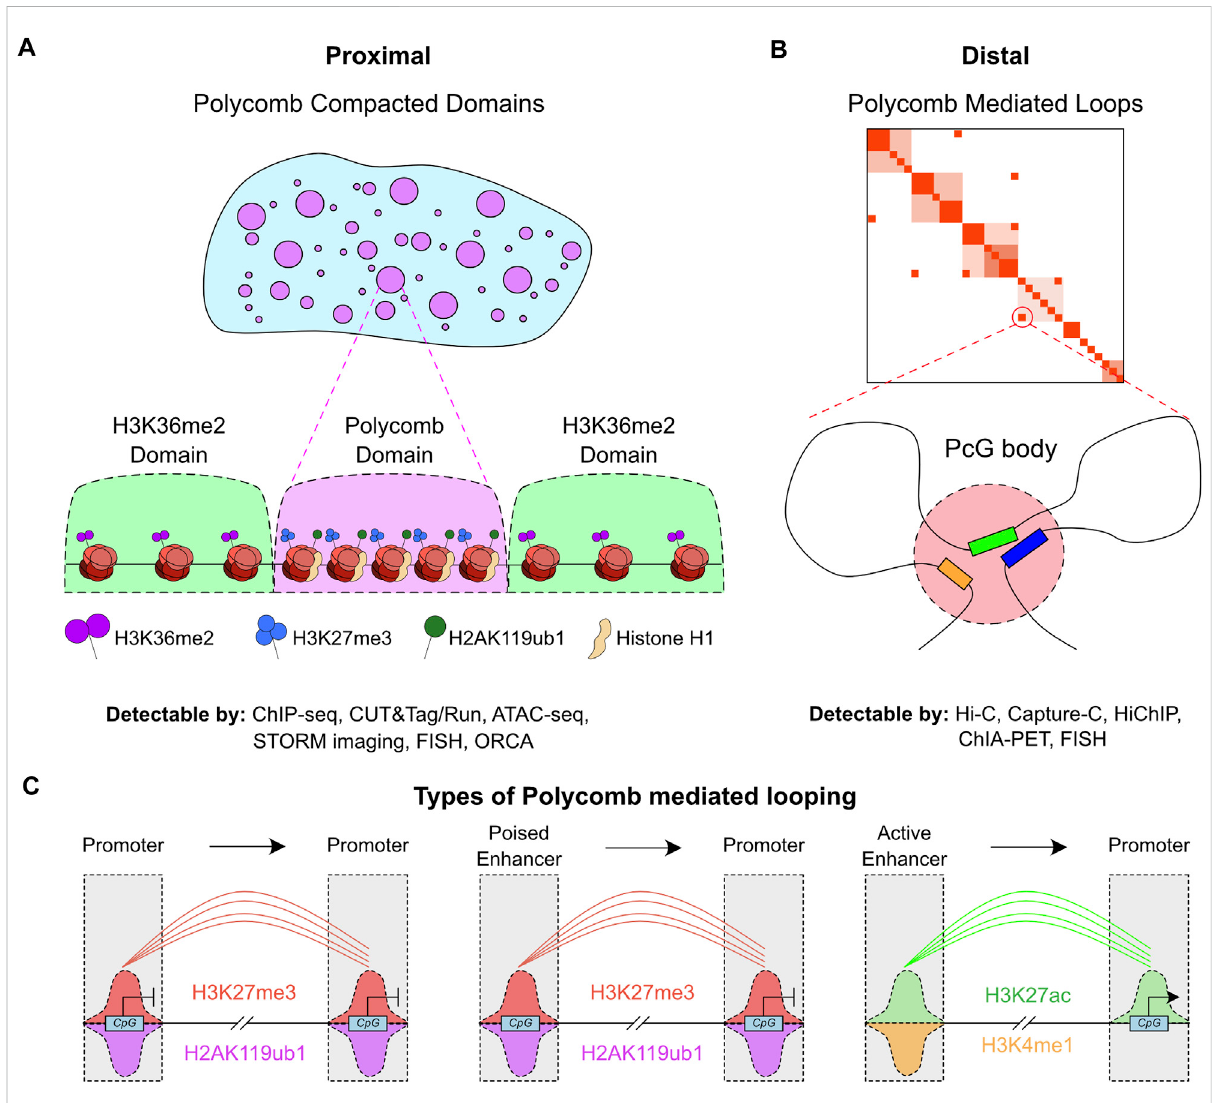
FIGURE 1 Divergent mechanisms of chromatin structure regulation by PcG. (A) Illustration of nuclear (blue) clusters containing Polycomb domains (purple). These proximal domains are occupied by H3K27me3, H2AK119ub1 and Histone H1, while boundary domains are enriched in H3K36me2 (green). Techniques that can be used to measure Polycomb domains and their associated compaction and histone modi fi cations are listed underneath the graphic. (B) Illustration of distal Polycomb mediated loops, with example chromatin capture contact map, which involve multiple regions that are distal in 3D-space contacting each other in stable Polycomb bodies. Techniques that can be used to measure Polycomb mediated loops are listed underneath the graphic. (C) Cartoon of the different genomic features that undergo Polycomb mediated looping, and the histone modi fi cations associated with these